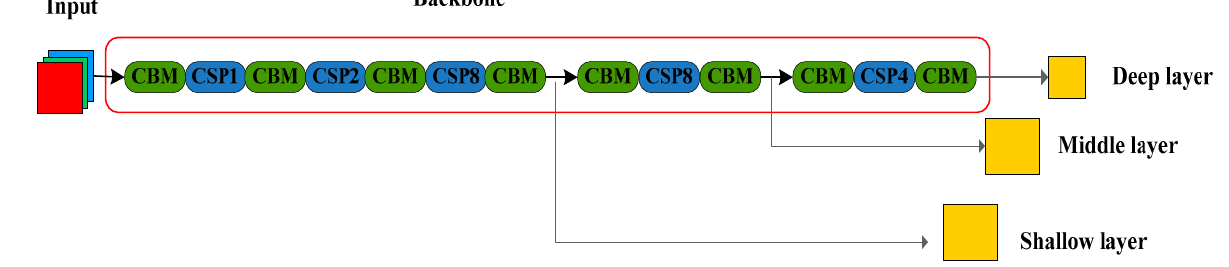
Figure 1. The backbone network structure of YOLO-v4.